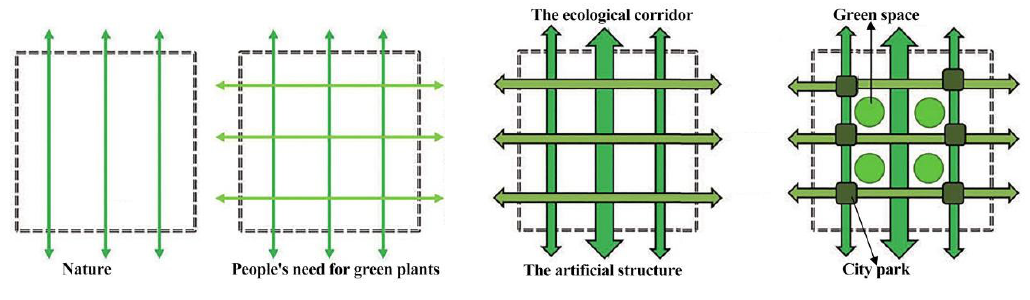
Fig. 4 Schematic diagram of system construction of green space